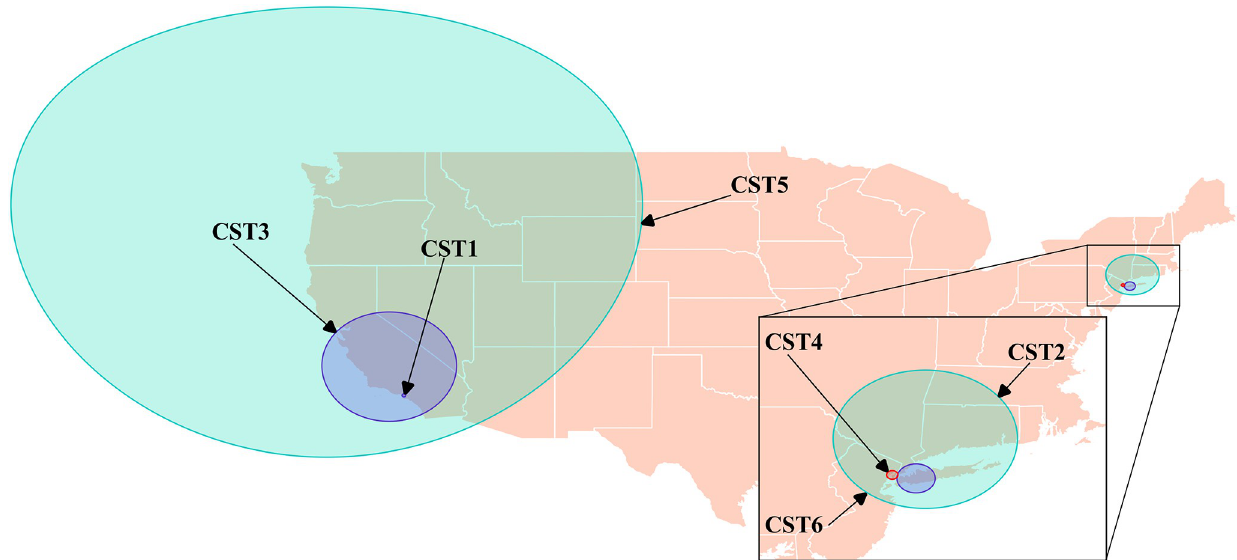
Fig 6. Locations of statistically significant space-time clusters of high levels of calls concerning cannabinoids identified using the spatial scan statistic with Bernoulli and space-time permutation models, based on data from dog-associated poisoning calls to the Animal Poison Control Center related to cannabinoids in the continental US (2005–2014).